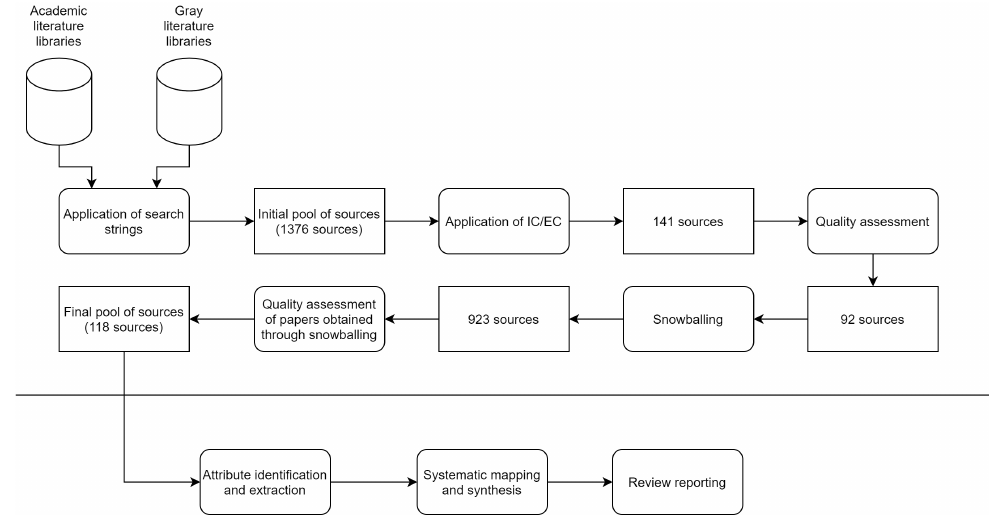
Figure 1. Phases of the literature